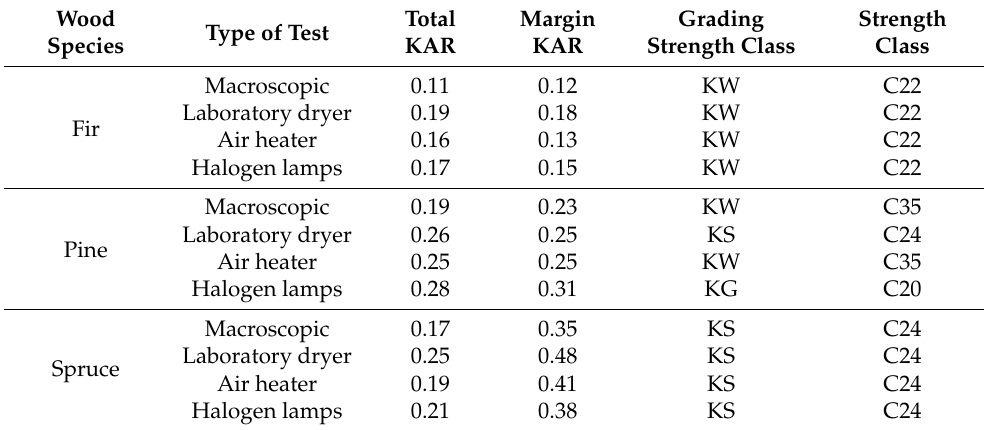
Table 2. Knot area ratio in the critical cross-section of the elements with classification to quality and strength class, according to References [44,51], in the whole scope of